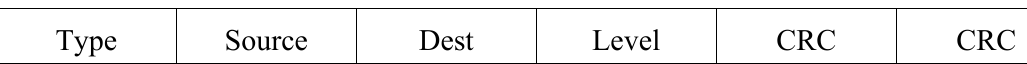
Figure 3. Format of feedback-route